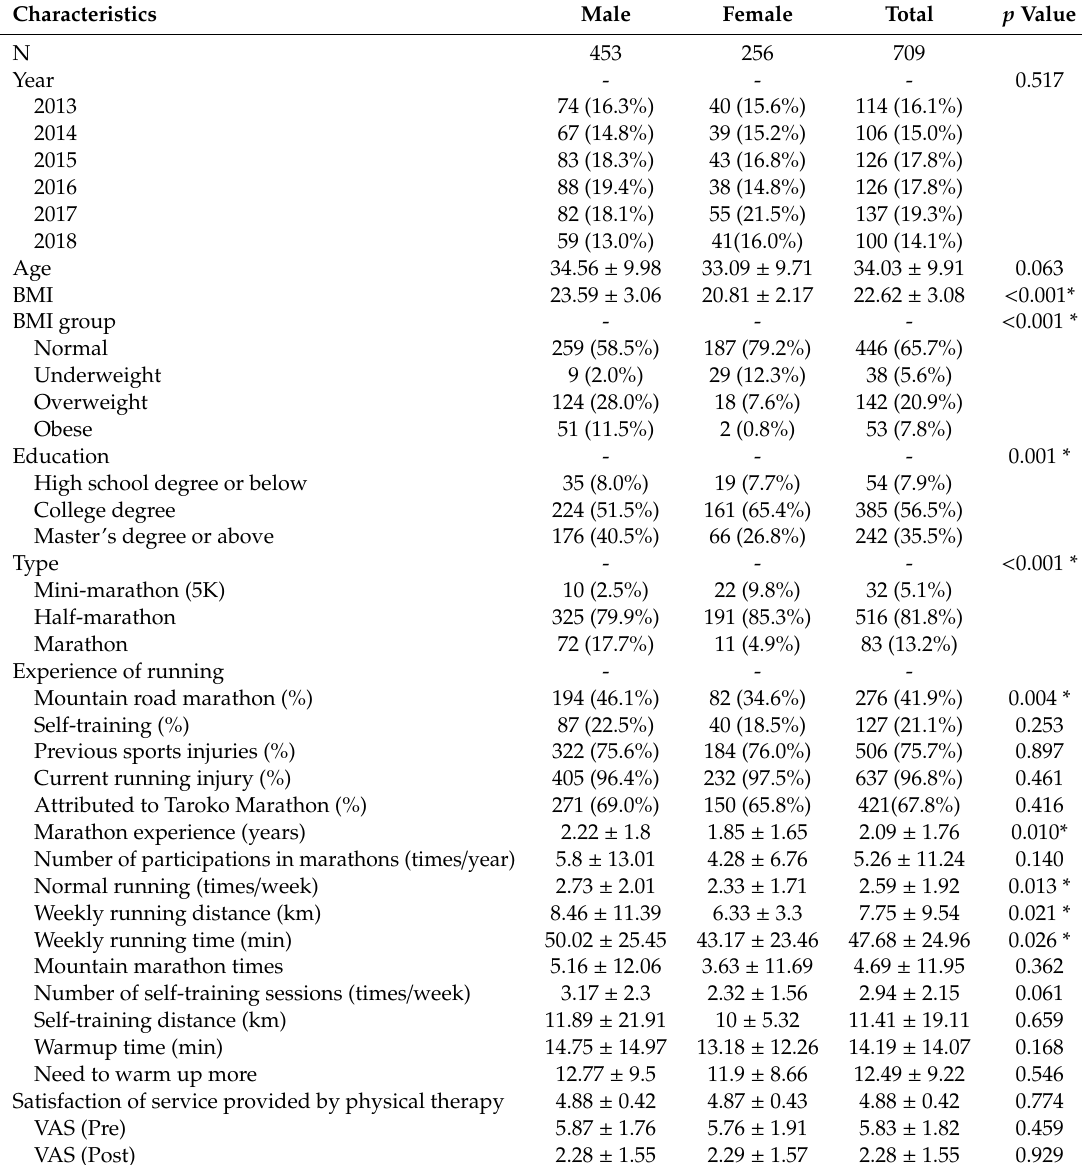
Table 1. Demographic data for the runners who participated in this study from 2013 to 2018 (n = 709).